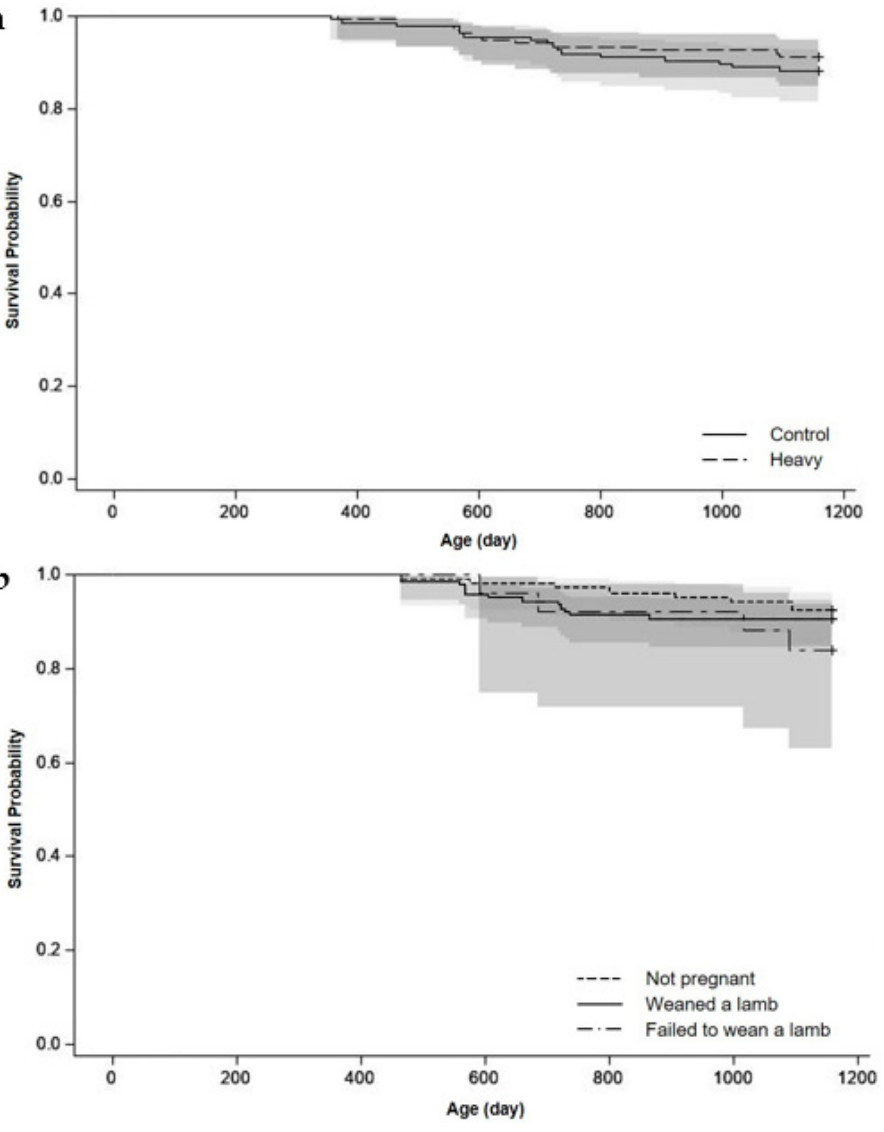
Figure 4. Actual survival curves and 95% confidence interval (grey area) of the ewes based on ( a ) treatments (control or heavy) and ( b ) ewe lamb status (not pregnant or weaned a lamb or failed to wean a lamb) for the three years of the experiment until 1159 days of age. Ewes were only culled for welfare reasons.